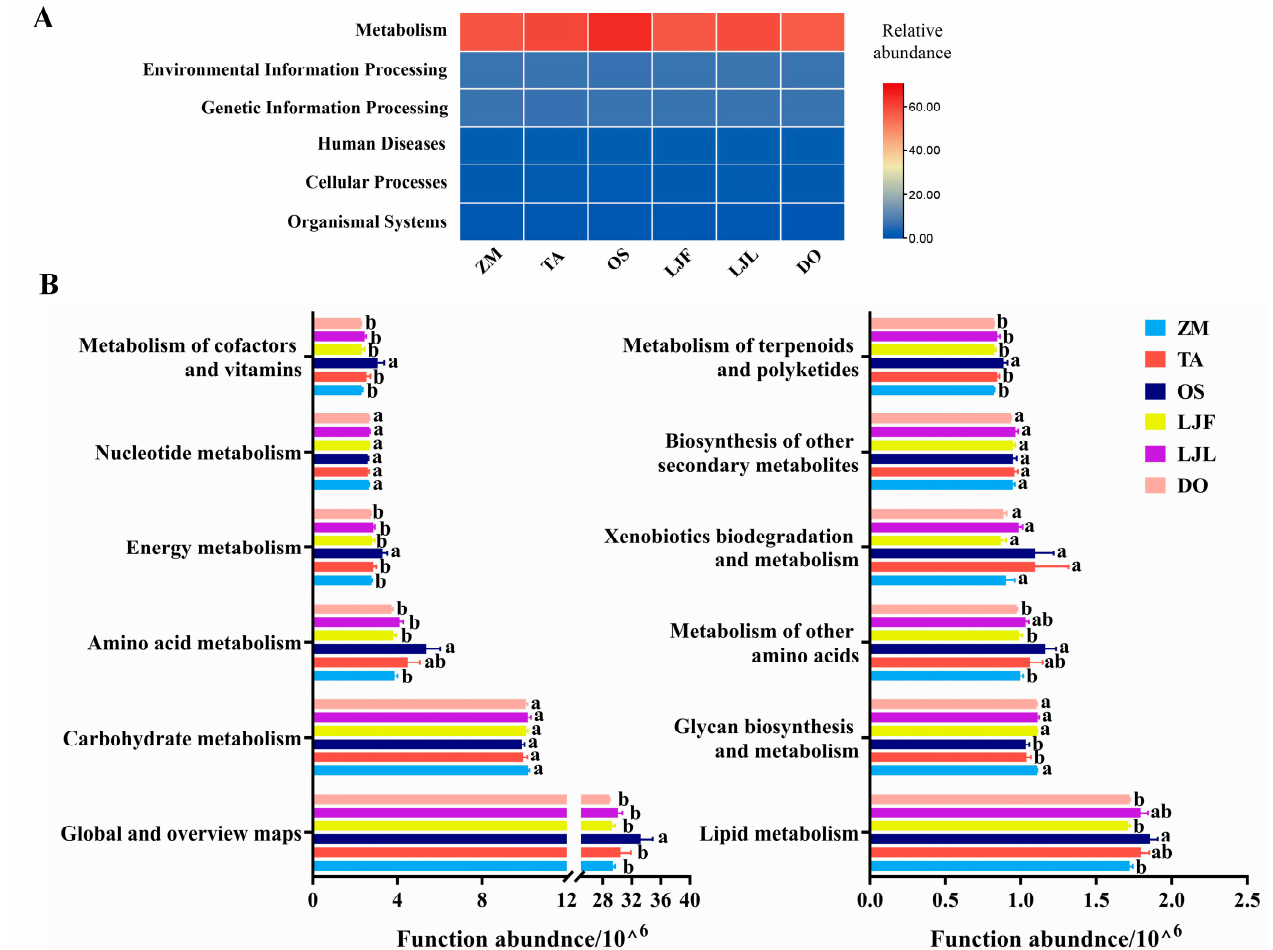
Figure 6. Comparison of KEGG function prediction in the gut bacterial communities of Spodoptera frugiperda fed on different host plants. ( A ) heatmap of pathway level one; ( B ) analysis of metabolic pathway level two. Abbreviations in the figure represent different treatments: ZM, maize; TA, wheat; OS, rice; LJF, honeysuckle flowers; LJL, honeysuckle leaves; and DO, Chinese yam. Different lowercase letters above bars indicate significant differences among different treatments ( p < 0.05, One-way ANOVA).